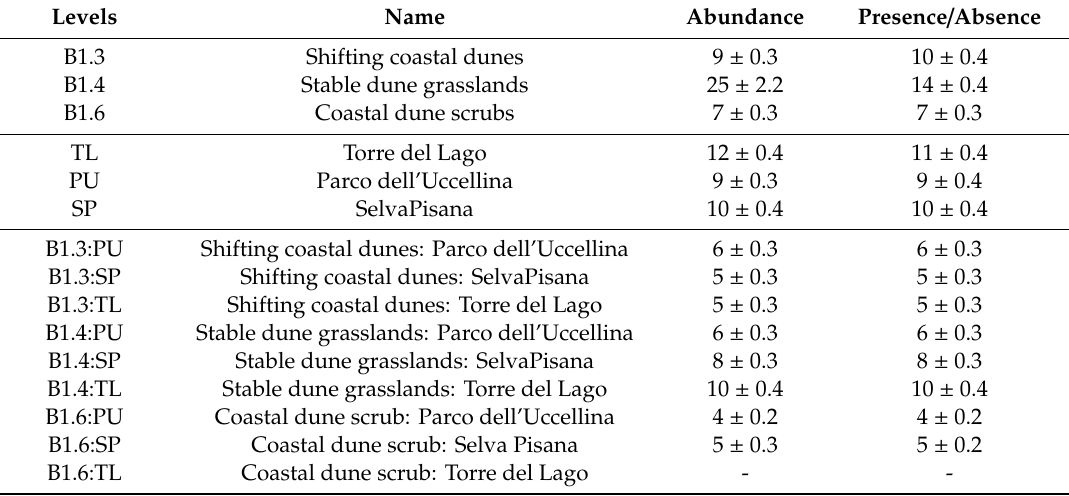
Figure 4. Profile of MultSE based on Bray–Curtis dissimilarity for each EUNIS habitat type within the three sampling areas. n = number of plots. TL = Torre del Lago; PU = Parco Uccelllina; SV = Selva Pisana. Table 4. Estimated number of plots and associated standard error indicating where precision stabilizes considering habitat, SAC and their interaction. Breaking points of MultSE (i.e., where the linear relation changes) were estimated by segmented